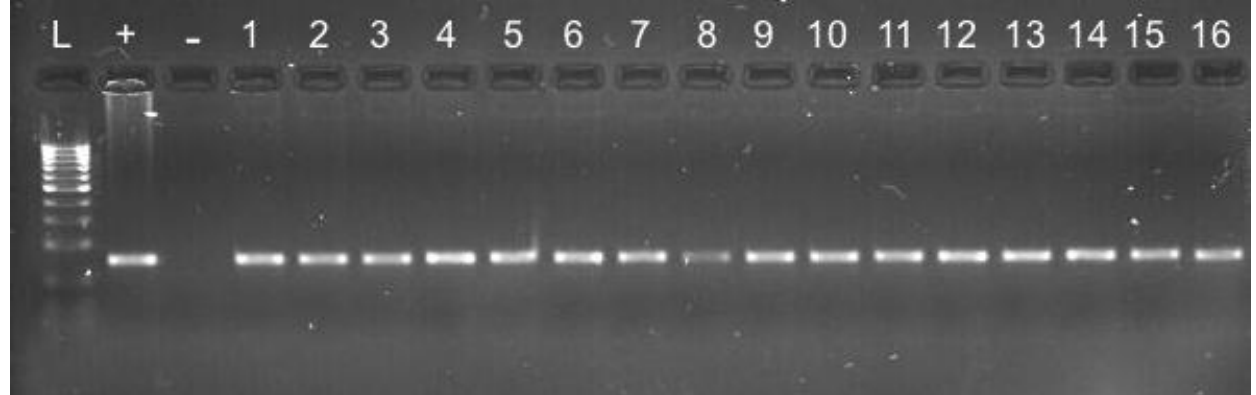
Figure 1 . Electrophoresis gel showing 100bp DNA ladder (L), positive control (+) lane, empty negative control lane (–), and samples 1-16 as indicated in the corresponding